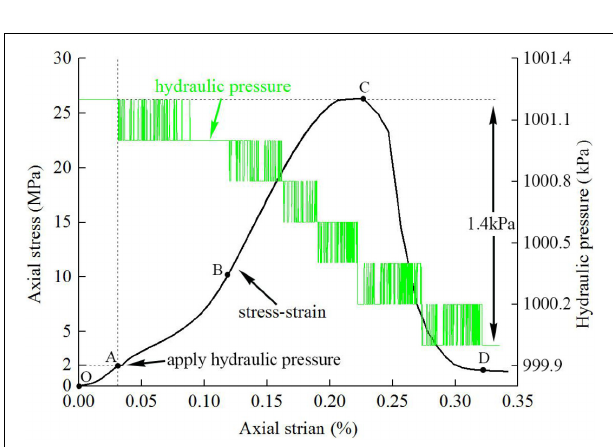
FIGURE 8 | Stress–strain and hydraulic pressure curves for an internal fracture specimen subjected to a stable hydraulic pressure of 1